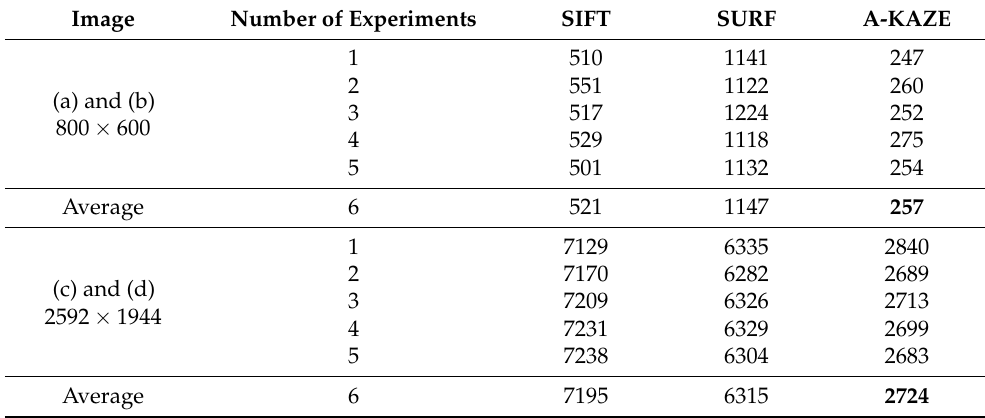
Table 1. Comparison of time taken for feature point computation and matching (unit: